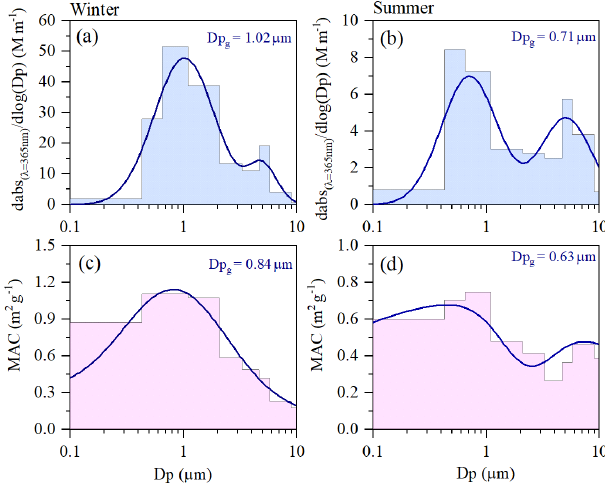
Figure 3. Size distributions of abs λ = 365nm and MAC of PM 2 . 5 samples extracted by water during the winter and summer of 2017 in Xi’an. Dpg is the geometric mean diameter of